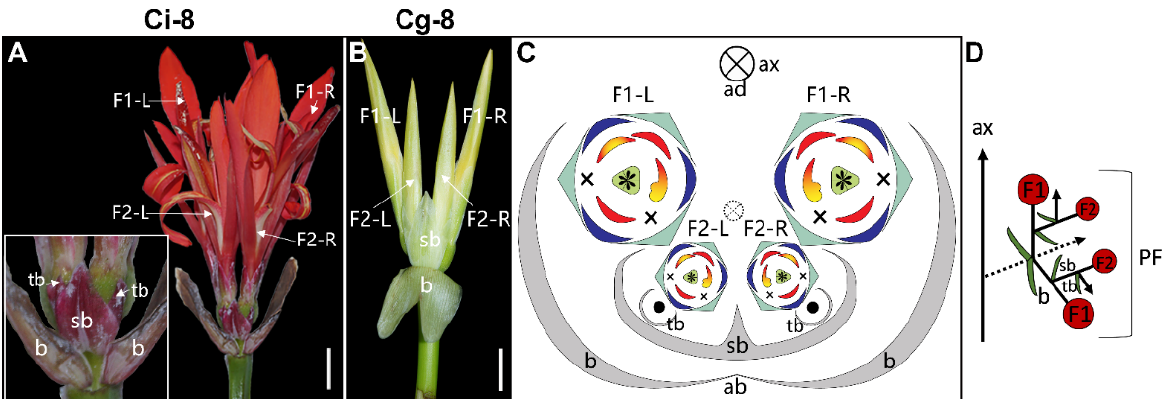
Figure 11. 4-flowered thyrse. The partial inflorescence photographs of ( A ) C. indica collection Ci-8, and ( B ) C. glauca collection Cg-8. ( C ) The partial inflorescence diagram for both Ci-8 and Cg-8. ( D ) Longitudinal scheme of the 4-flowered thyrse. Dashed circle with a × in ( C ) and the dotted arrow in ( D ) indicate the early aborted raceme axis of the truncated thyrse. Bars = 1 cm.